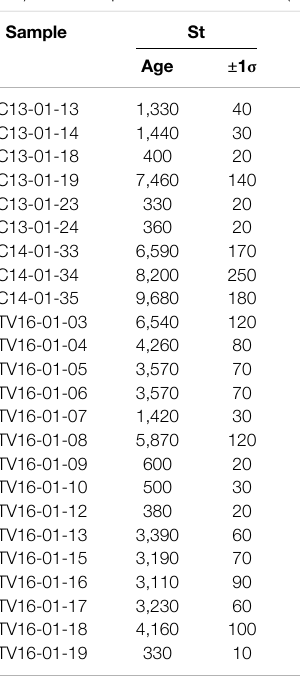
TABLE2| Allthenew 10 BewereagescalculatedusingCRONUSv.3(Balcoetal., 2008) and are reported with 1 σ internal (analytical)